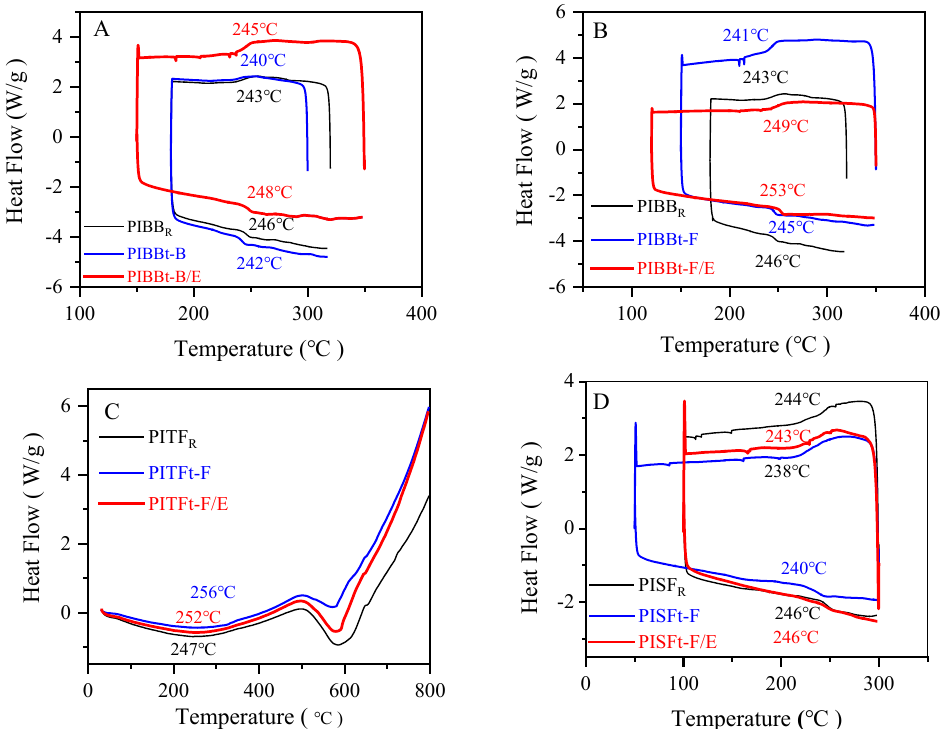
Figure 5. DSC thermograms of CPI films capped with different blockers: ( A ) PIBB R , PIBB t-B and PIBB t-B/E ; ( B ) PIBB R , PIBB t-F and PIBB t-F/E ; ( C ) PITF R , PITF t-F , and PITF t-F/E ; ( D ) PISF R , PISF t-F and PISF t-F/E . The DSC thermograms of the PIBBs are presented in Figure 5A,5B, where no apparent glass transitions (T g ) are detected for all PIBBs below 350 °C. The T g values measured at the second heating process are slightly higher than the first cooling process. This may be associated with further condensation or cross-linking between the tail groups of polyimides after the first heating process, while the temperature is still lower than the decomposition temperature. The T g values measured for PIBBs are 242-253 °C. Since BPDA is a rigid structure and the polyimide ring is difficult to rotate, the polyimide film has good heat resistance. The T g values of PIBB t-B/E and PIBB t-F/E films are a little higher than PIBB R, because the PIBB molecular weight increases due to the coupling effect of EG (Figure 7A,B). The DSC curves of PITFs and PISFs are shown in Figure 5C,D and their thermal stability is similar to PIBBs’. The T g values of PITF t-B/E and PISF t-F/E films are higher than PITF R and PISF R as the molecular weights are increased by the coupling effect of EG (Figure 7C,D). In general, T g values of polyimide film are not impacted much by the two- step capping method, meaning that the end-capping PI films can be processed in a similar way to general PIs.